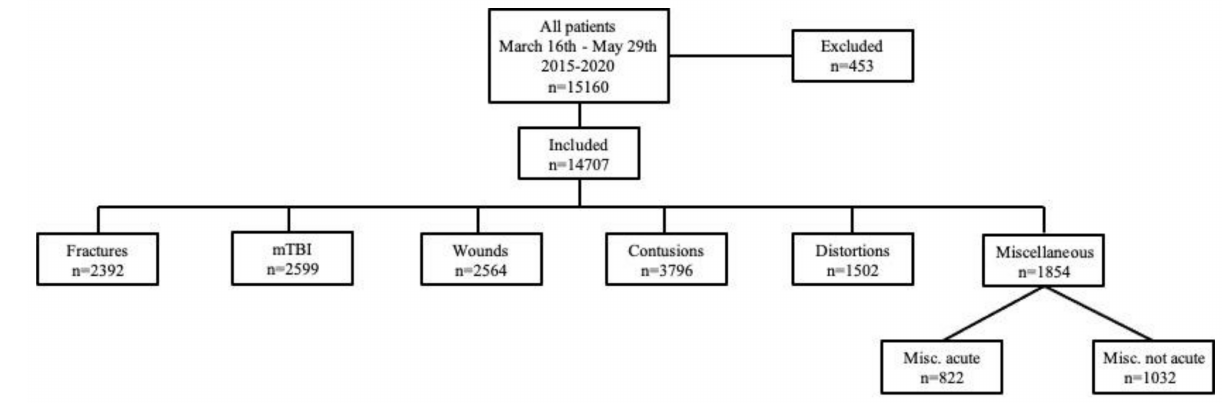
Figure 1. Flow chart of the overall study population according to categorised injuries. Table 1. Overview of the injuries categorised according to the year of